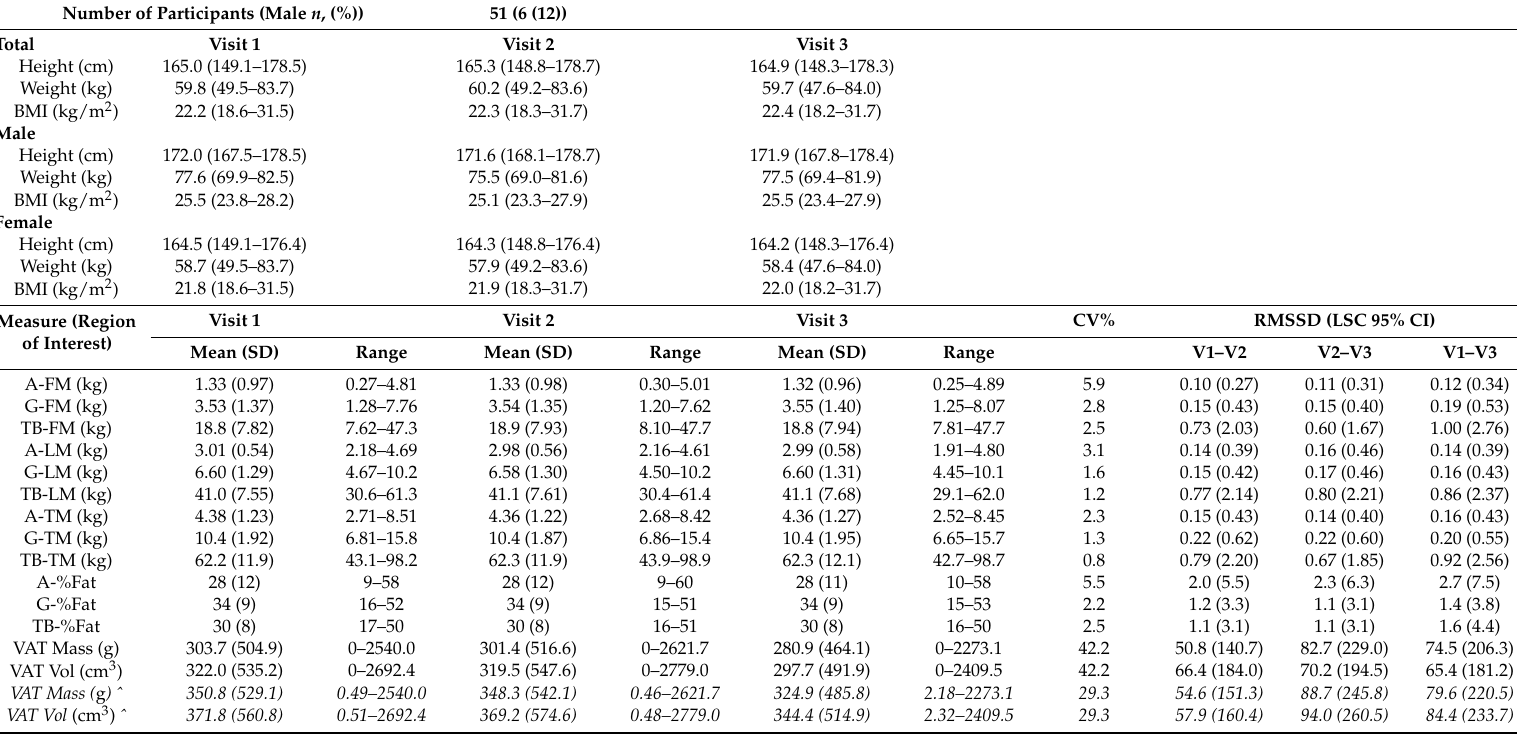
Table 1. Participant characteristics and body composition and coefficient of variation by region of interest over three